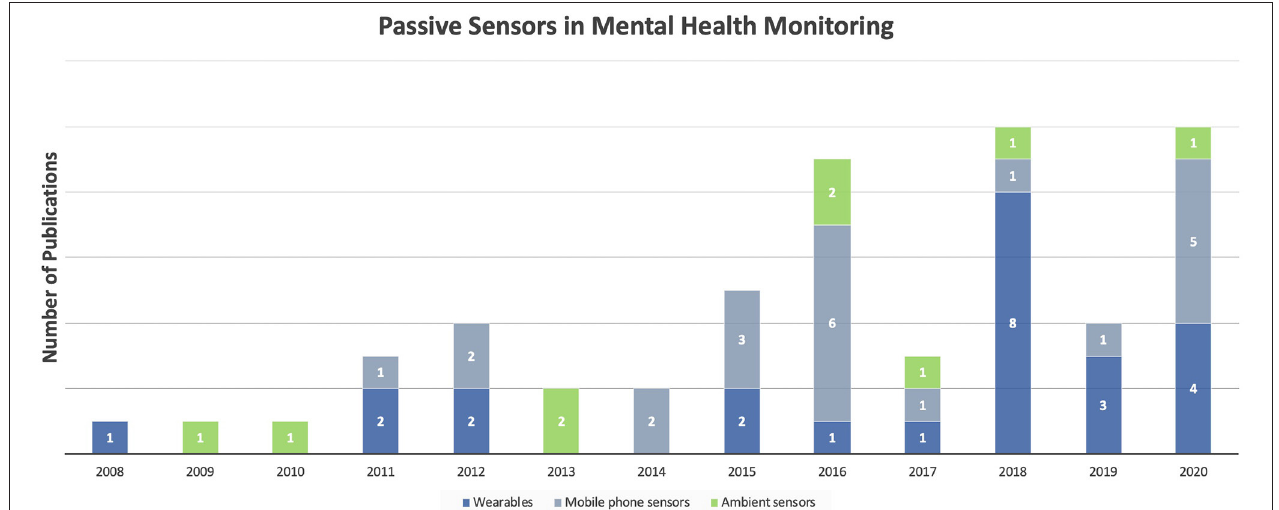
FIGURE 2 | Number of publications investigating monitoring systems in mental health from 2008 to